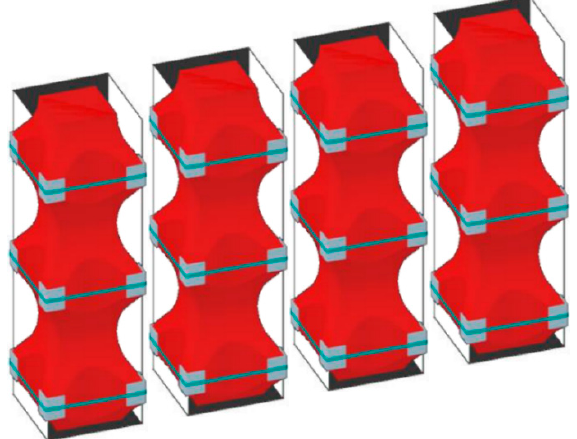
Figure 28. How the design criteria of the CAM system divide a masonry wall into juxtaposed confined columns to calculate the number of horizontal straps.